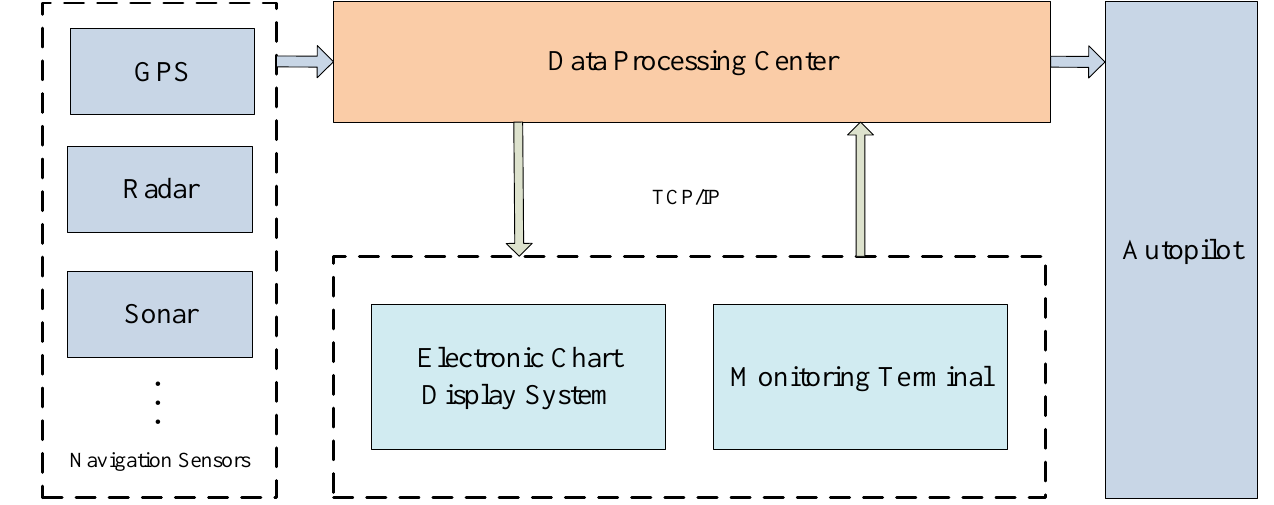
Figure 9. The framework of an intelligent vessel navigation system.